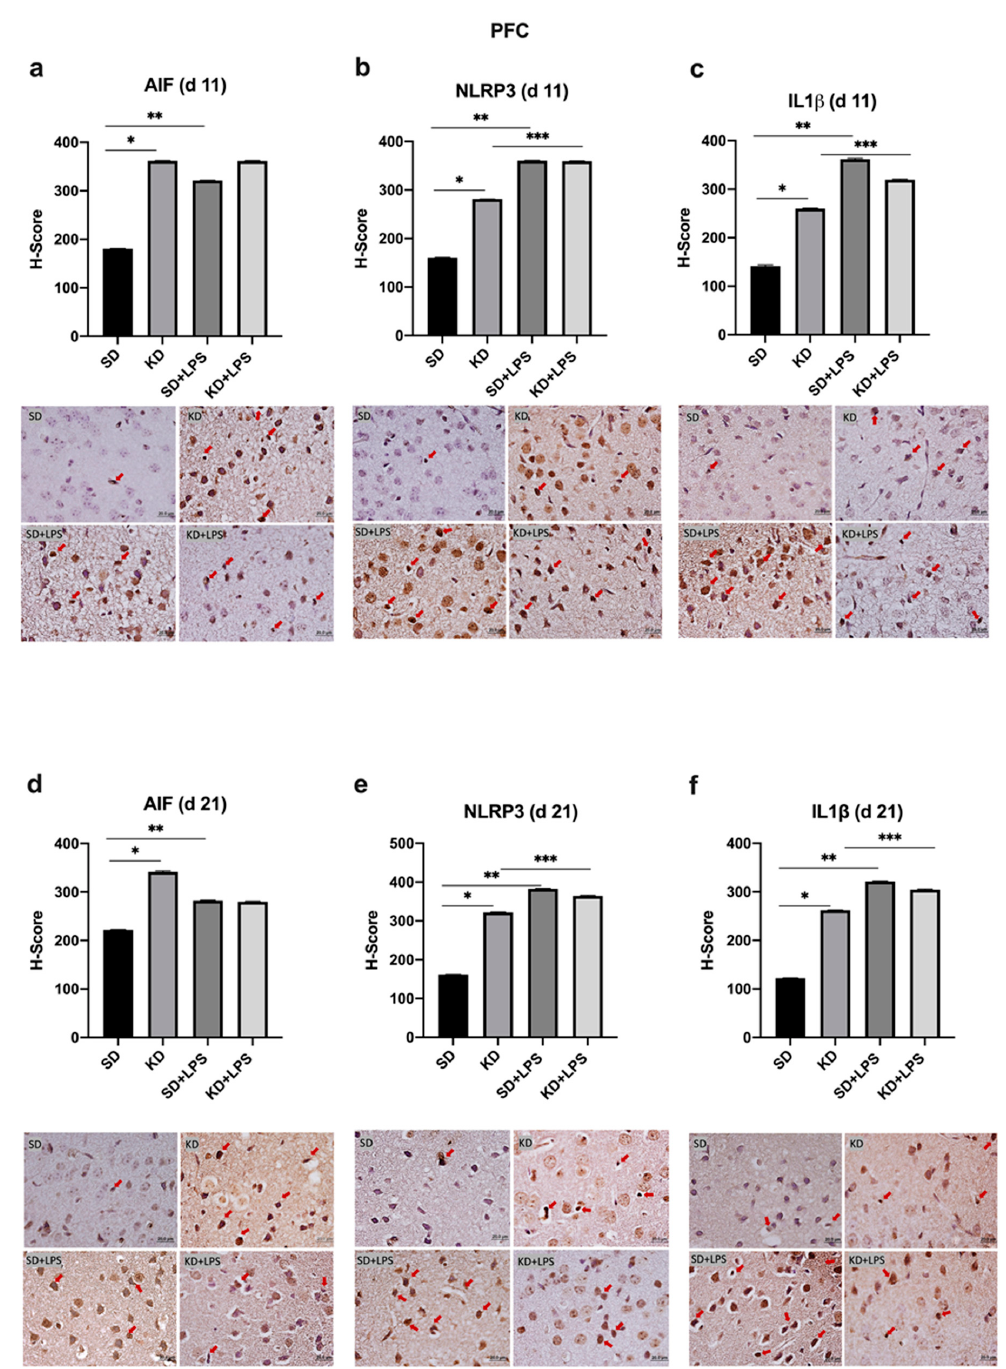
Figure 4. Immunohistochemical H-scoring and staining of the prefrontal cortex (PFC) with AIF, NLRP3 and IL1 β on postnatal days PN11 and PN21. IHC images are compatible with the graphic